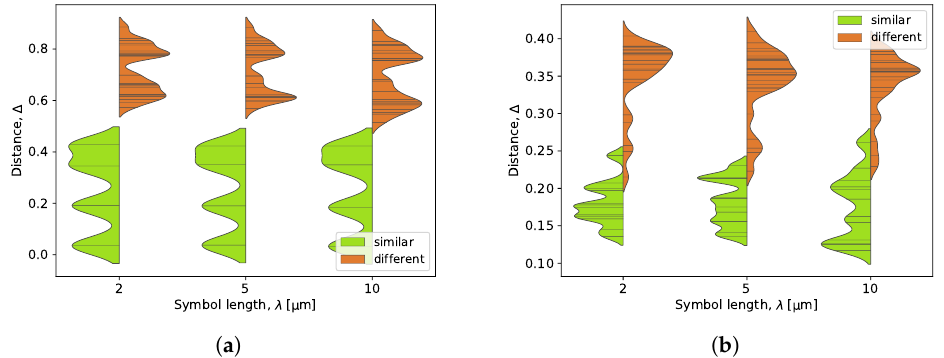
Figure 8. Distribution of distance ∆ calculated for two benchmarks using various values of symbol length λ : ( a ) benchmark composed of OTAs; ( b ) benchmark composed of NAND and OR